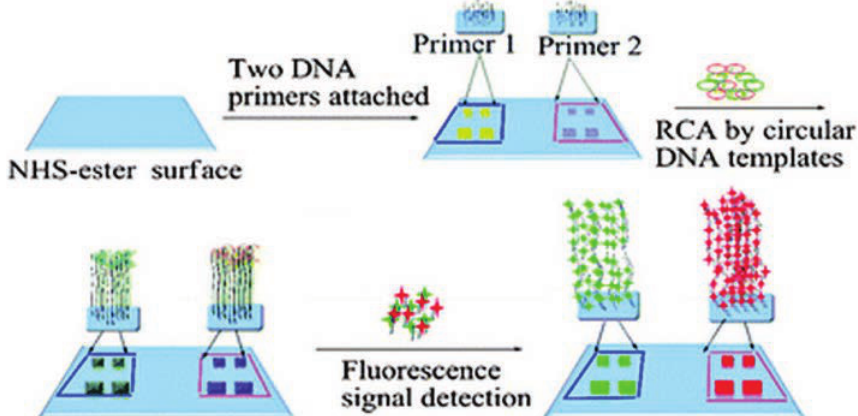
Figure 10. Preparation of a two-color DNA microarray. Reprinted with permission from [57]. Copyright 2012 Royal Society of Chemistry